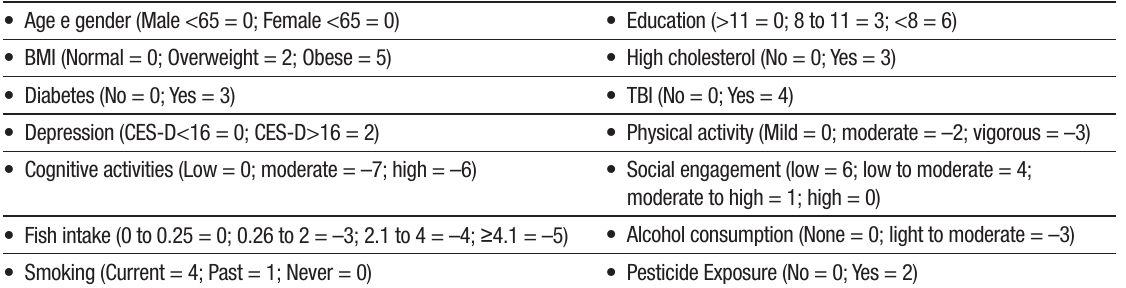
S1 Table. ANU-ADRI items and scoring (Adapted by Anstey et al.). 24